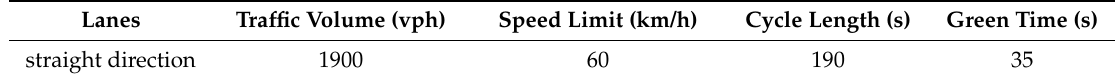
Table 1. Summary of intersection characteristics. Figure 2. Graphical illustration of the intersection of Naoshikou Street and Xuanwumen West Street.